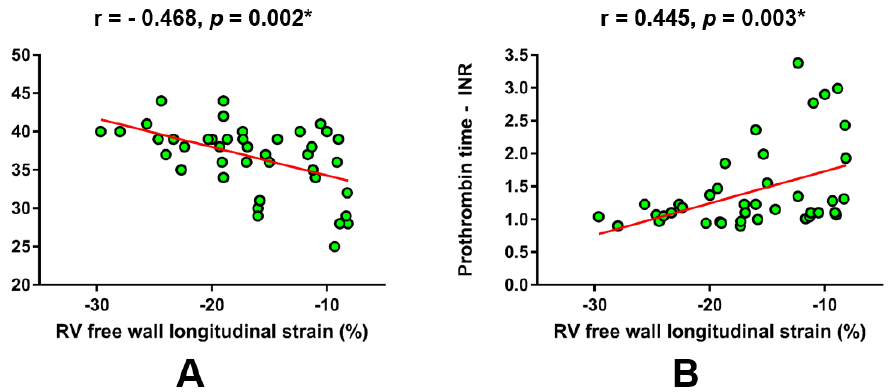
Figure 2. Linear regression plots showing the correlation of RV free wall longitudinal strain with respect to laboratory parameters that reflect synthetic liver function. ( A ) albumin, ( B ) prothrombin time - international normalized ratio. * Significant statistical association at two-tailed level. r-Pearson’s correlation coe ffi